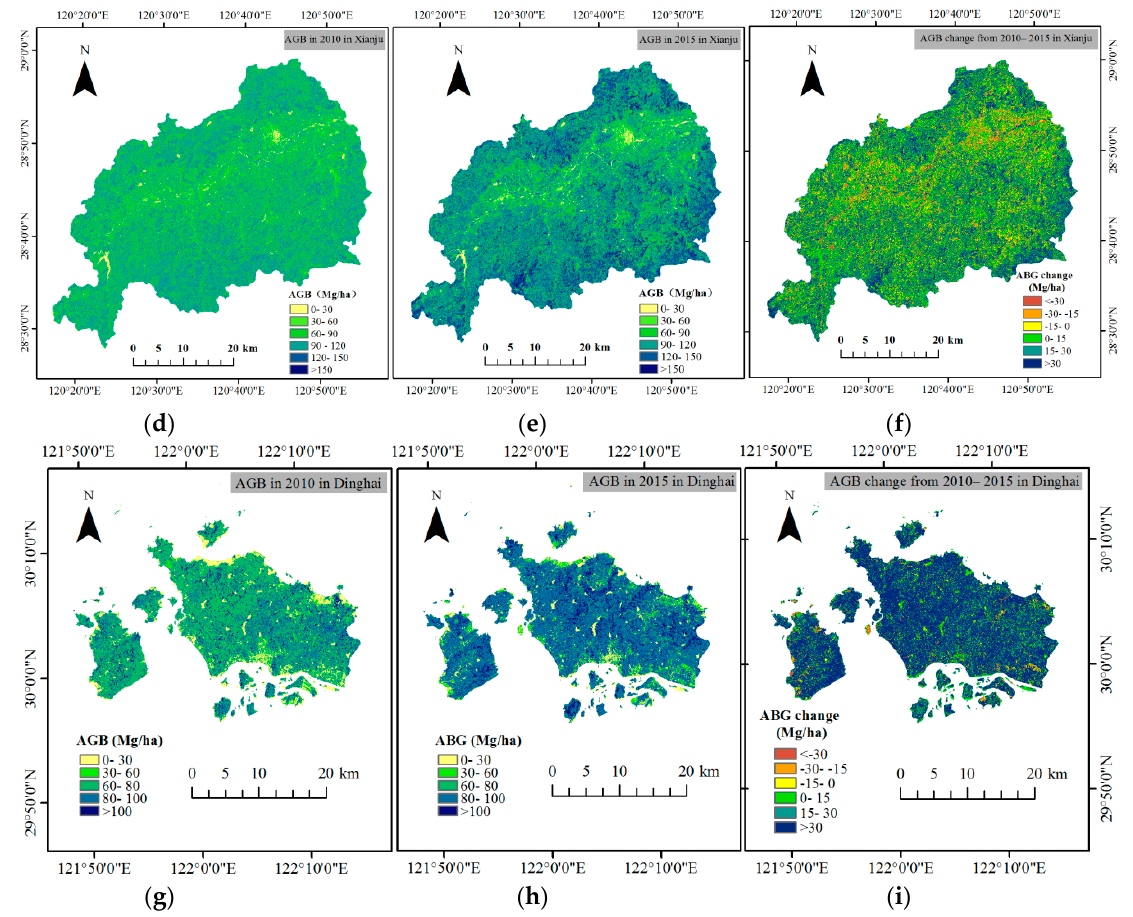
Figure 6. AGB and change maps in the three regions: ( a ) AGB in 2010 in Wuyi; ( b ) AGB in 2015 in Wuyi; ( c ) AGB change from 2010 – 2015 in Wuyi; ( d ) AGB in 2010 in Xianju; ( e ) AGB in 2015 in Xianju; ( f ) AGB change from 2010 – 2015 in Xianju; ( g ) AGB in 2010 in Dinghai; ( h ) AGB in 2015 in Dinghai; ( i ) AGB from 2010–2015 in Dinghai.